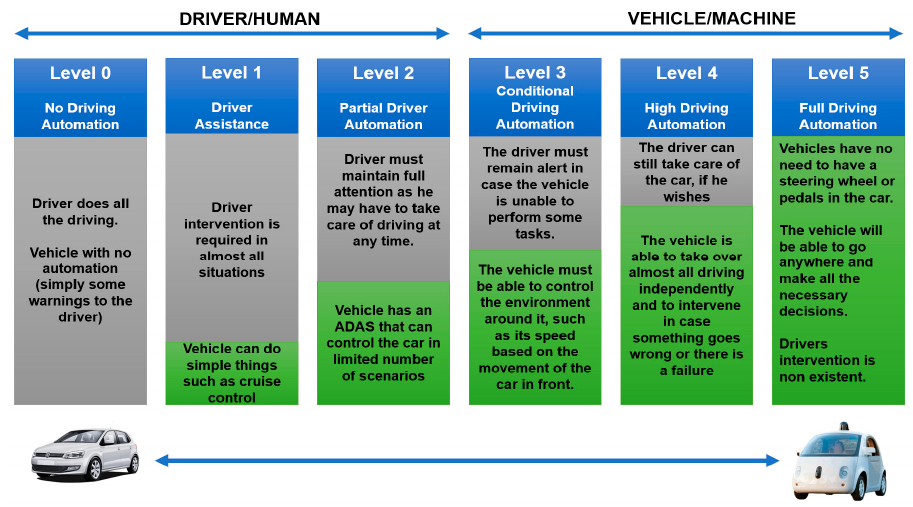
Figure 7. Level of automation of autonomous